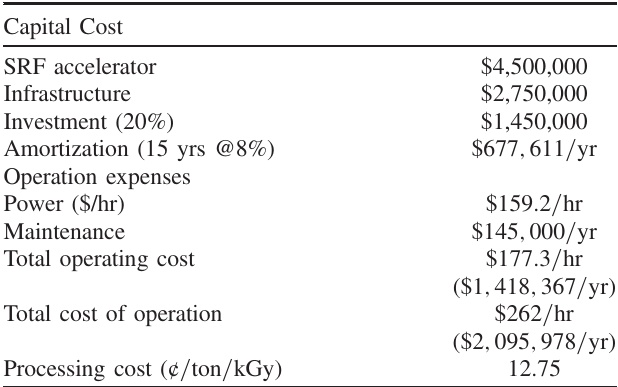
TABLE VIII. Estimated costs of operation and material